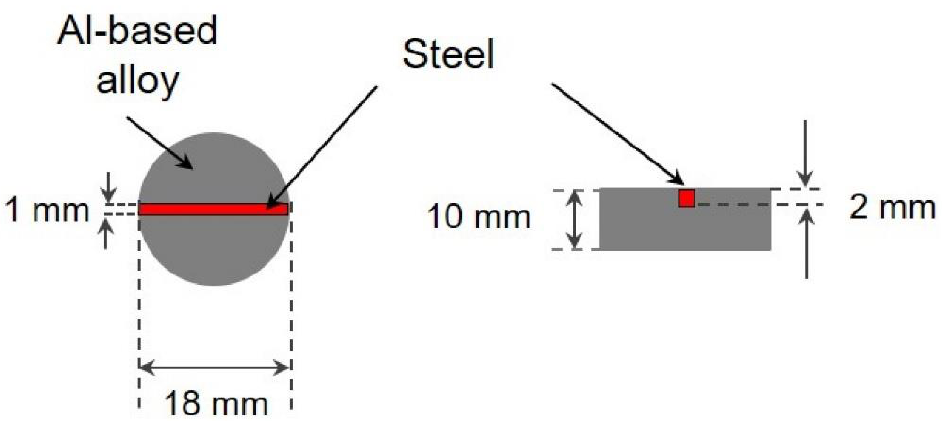
Figure 2. Galvanic coupled Al-based alloy – mild steel samples used for alternating immersion and salt spray